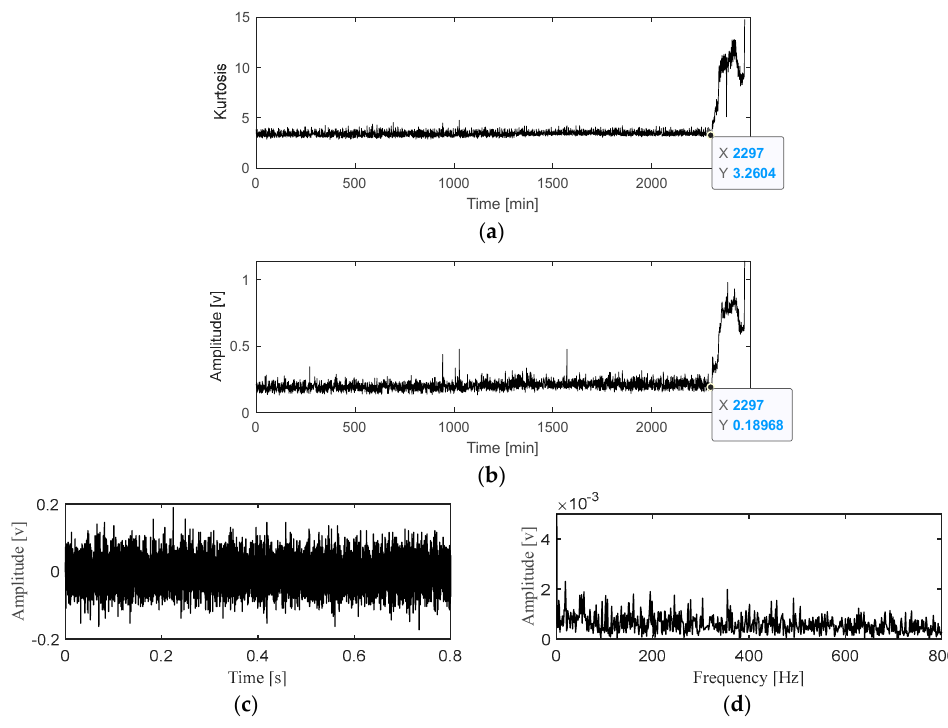
Figure 7. Vibration signal of the bearing’ early weak fault stage: ( a ) Kurtosis index of the selected bearing over its whole lifecycle; ( b ) Amplitude of the selected bearing over its whole lifecycle; ( c ) Time-domain waveform of the vibration data at 2297th mim; ( d ) Envelope spectrum of the signal as shwon in Figure 7c.